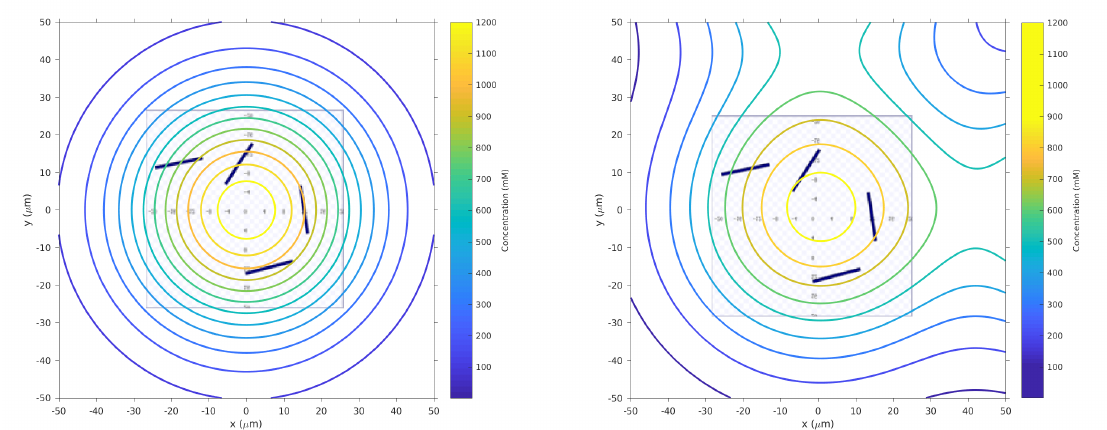
Figure 5. Obstacles shown as black rectangles are overlaid with the contour plots of the concentration in Figure 3. Note that this is a zoomed-in view of the domain to clearly show the obstacle locations.